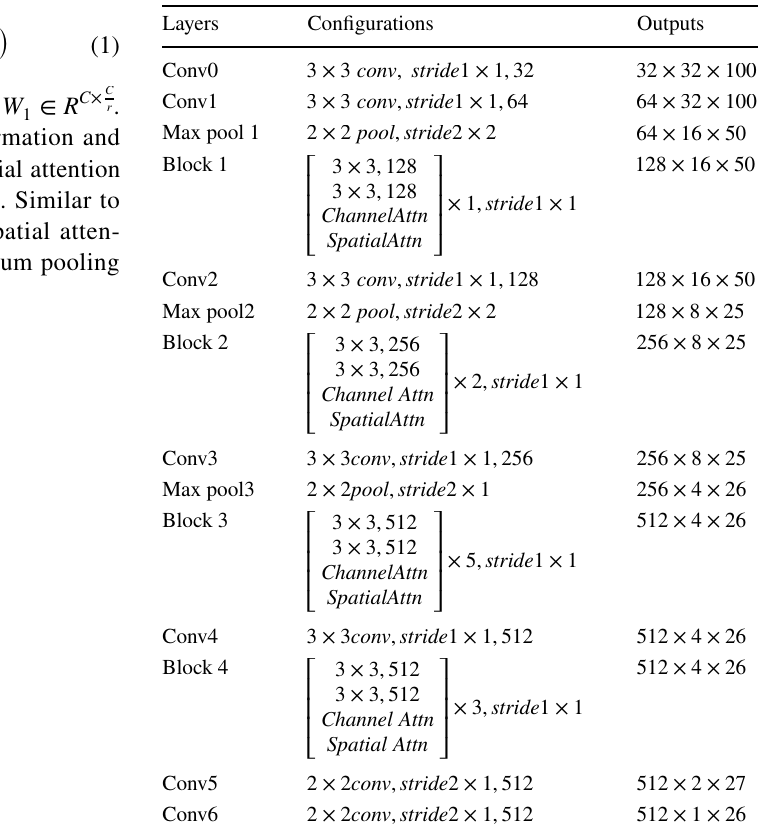
Table 1 Network